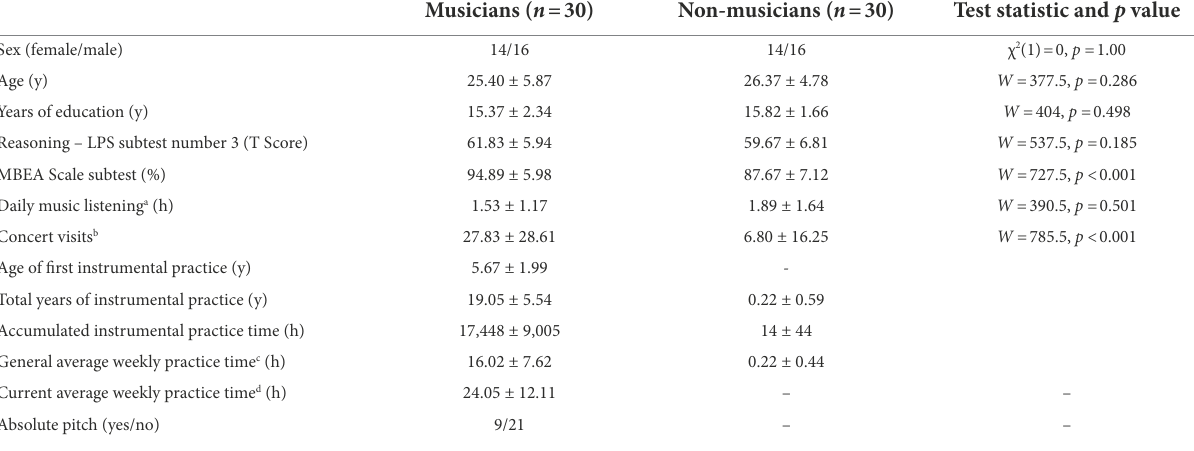
TABLE 1 Demographics and musical activity of the musician and non-musician